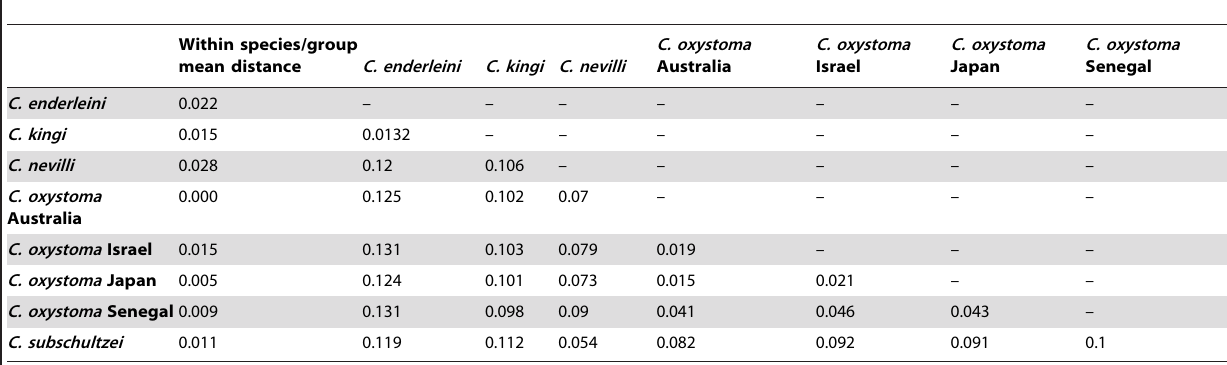
Table 2. Estimates of evolutionary divergence of sequence pairs between and within populations and